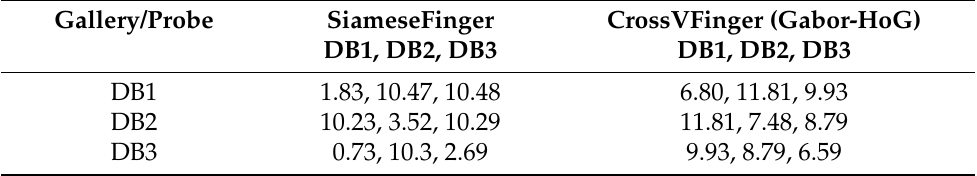
Table 4. Comparsion of the SiameseFinger with CrossVFinger on the MOLF database in terms of